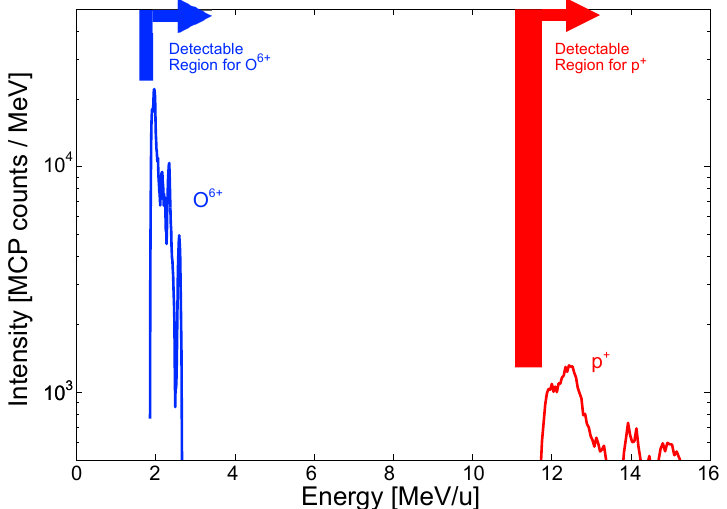
Figure 6. The proton and O 6+ spectra without CW laser heating. The energy spectrum for both protons and O 6+ ions extends from the minimum detectable energy to the maximum cut-off energy.